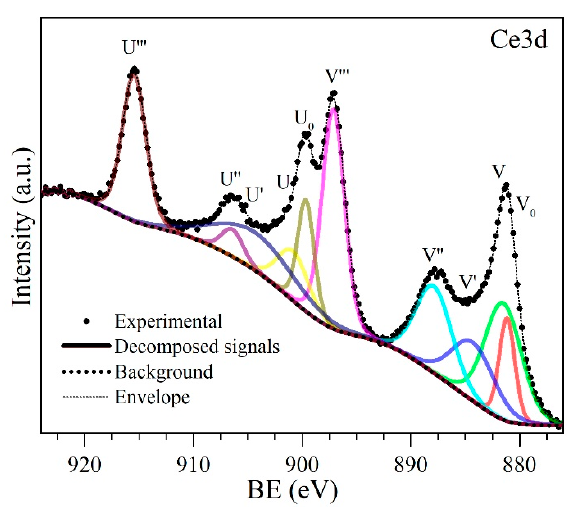
Figure 9. Decomposed high-resolution XPS Ce3d spectrum. U 0 , V 0 , U’, and V’ correspond to Ce 3+ , and U, V, U’’, V’’, U’’’, V’’’ to Ce 4+ [91] .